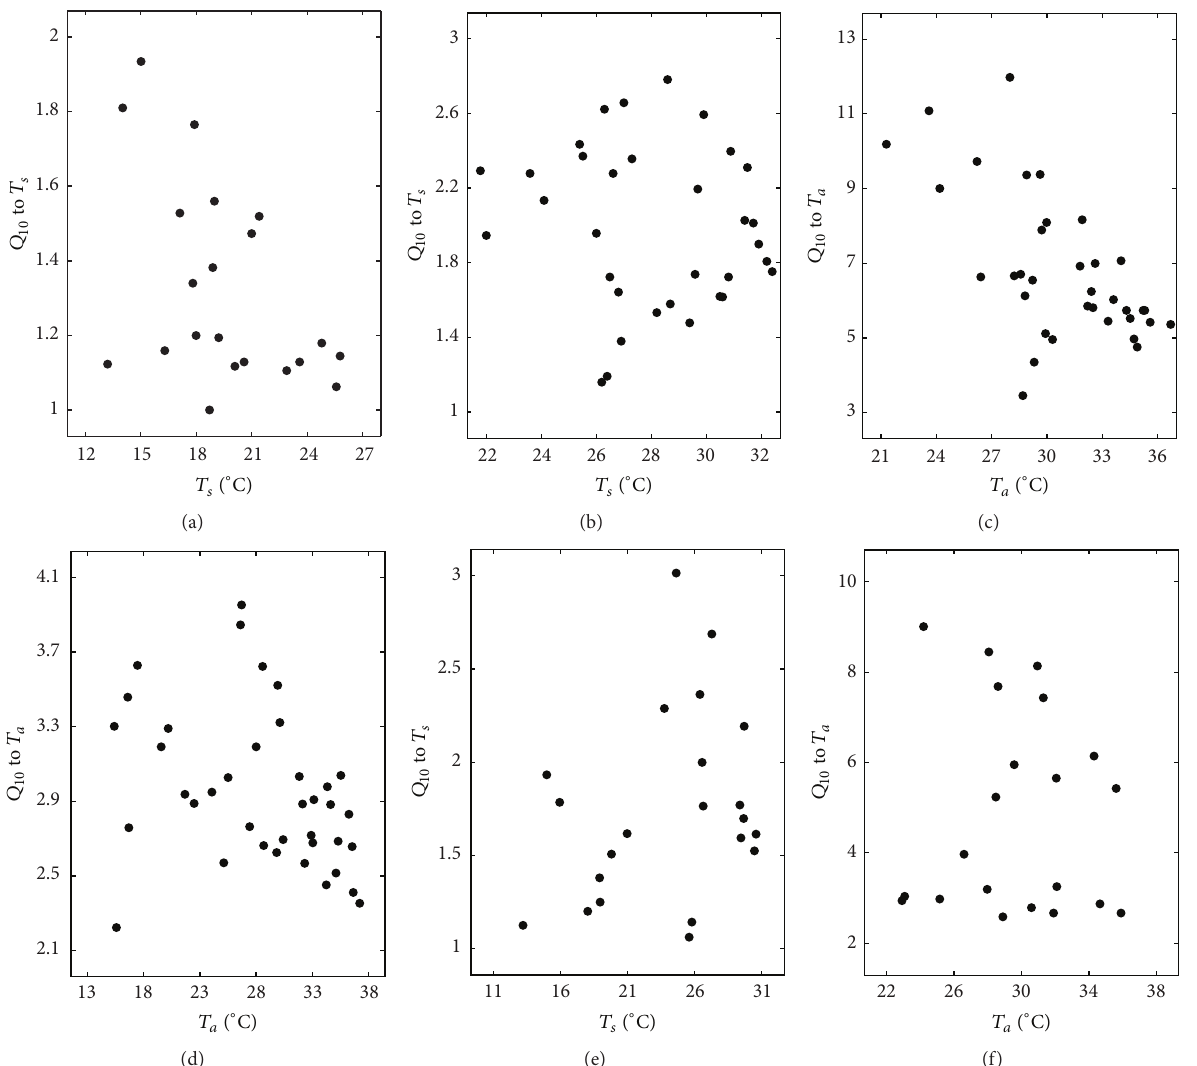
Figure 4: Responses of the temperature sensitivity ( 𝑄 10 ) to soil temperature at 5cm depth ( 𝑇 𝑠 ) and air temperature 10cm above the soil surface ( 𝑇 𝑎 ) in saline desert (a, c) and cropped farmland (b, d) and the responses of 𝑄 10 to 𝑇 𝑠 and 𝑇 𝑎 when taking the saline desert and cropped farmland data together (e, f).